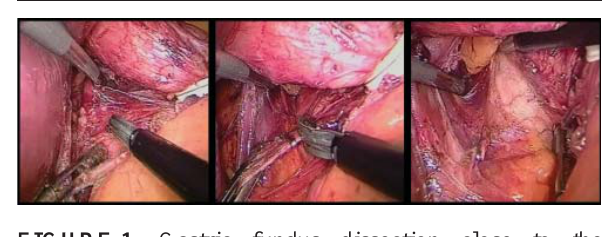
FIGURE 2 - SGC division, from the inferior splenic area (A and B) and the gastric-pancreatic vessels (C)